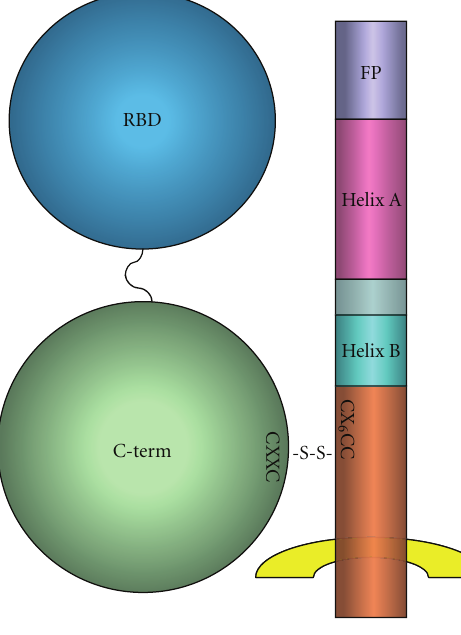
Figure 6: MLV Env protein. MLV Env protein consists of a complex between gp70 SU and p15E TM . The cartoon shows that gp70 has two domains, RBD at its N-terminus and “C-term” at its C-terminus, separated by a variable, proline-rich linker. P15E contains, from N- to C-terminus, the fusion peptide (FP), an N-terminal helical domain (helix A), a short C-terminal helical domain (helix B), and a C-terminal domain (light pink) which spans the viral membrane (yellow). Gp70 is exclusively external to the virus and is connected to p15E by a disulfide linkage between one of the two cysteines in a CXXC motif within its C-terminal domain and the last cysteine in a CX 6 CC motif in